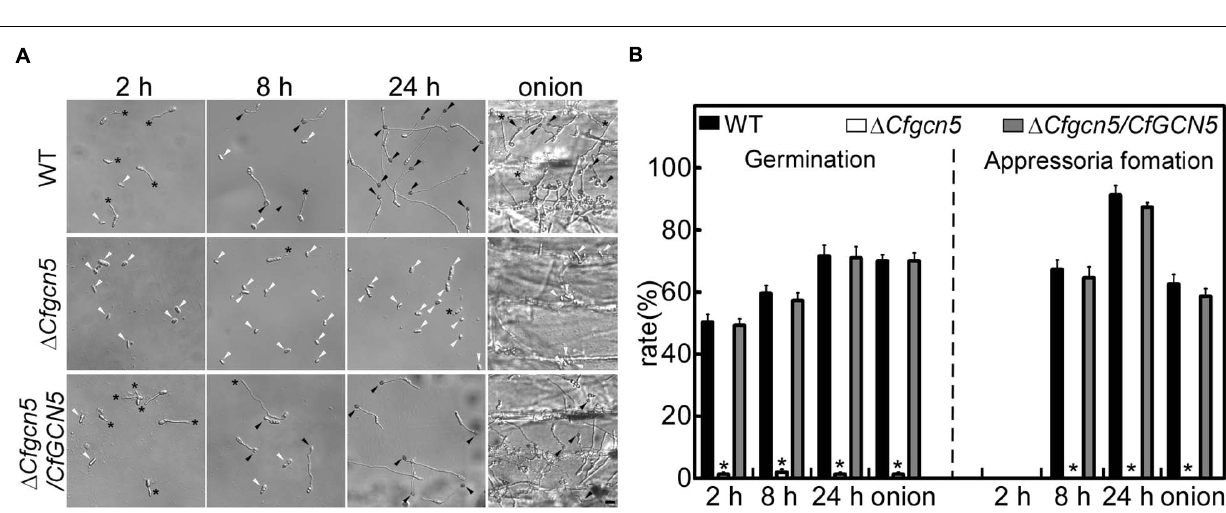
Frontiers in Microbiology |